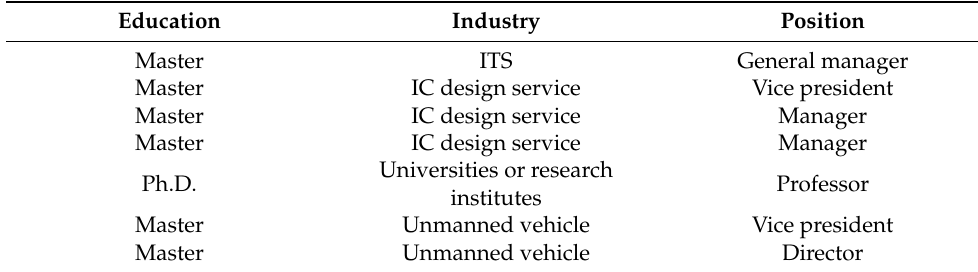
Table 2. Experts’